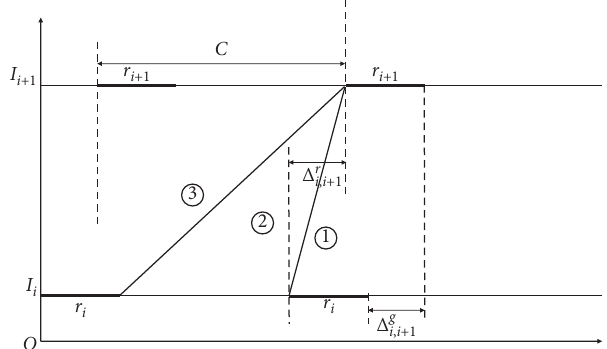
Figure 3: Classification of forward overlapping spatiotemporal figures according to